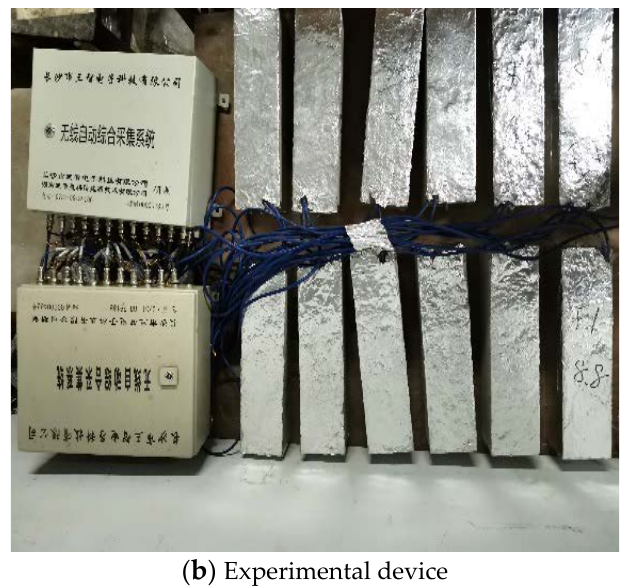
Figure 4. Test device of autogenous shrinkage, temperature and relative humidity (RH) of concrete.